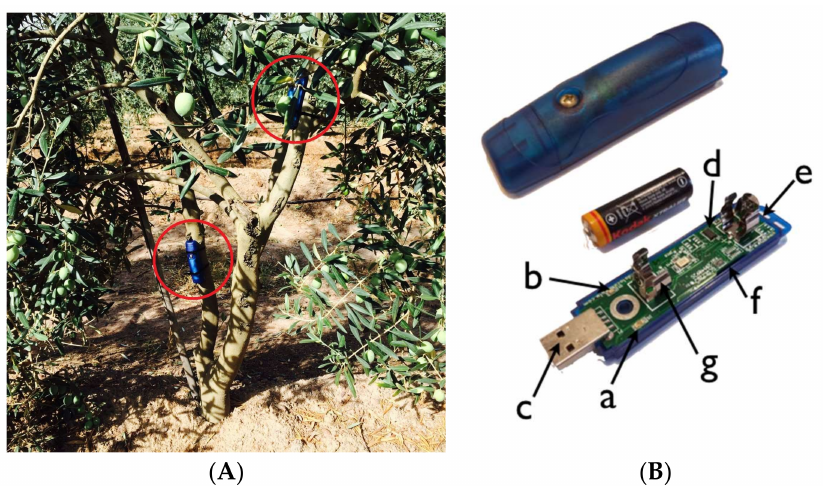
Figure 4. Three-axis accelerometers mounted on an olive tree ( A ) and the X16-1D accelerometer ( B ): a: the red LED data indicator, b: the blue LED status indicator, c: a type-A USB connector, d: an ADXL 345 sensor, e: an on/off button, f: a microSD card (under the circuit board) and g: the AA battery